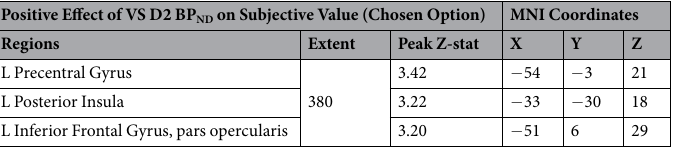
Table 3. Positive correlation between ventral striatum D2 BP ND and neural representations of subjective value of the chosen option. Average effects are reported across all subjects. Showing local maxima separated by 20 mm for cluster-forming threshold Z > 2.3, cluster-corrected p <